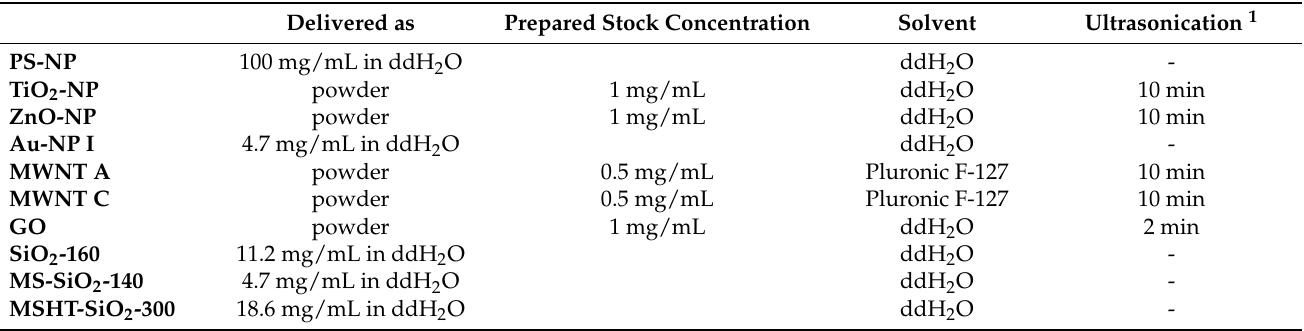
Table 1. ENM suspension